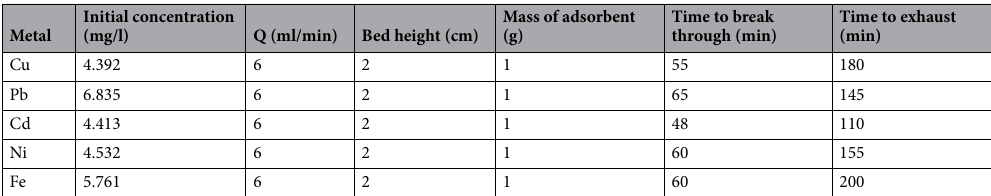
Table 2. Fixed-bed column parameters for heavy metal adsorption by IABB.